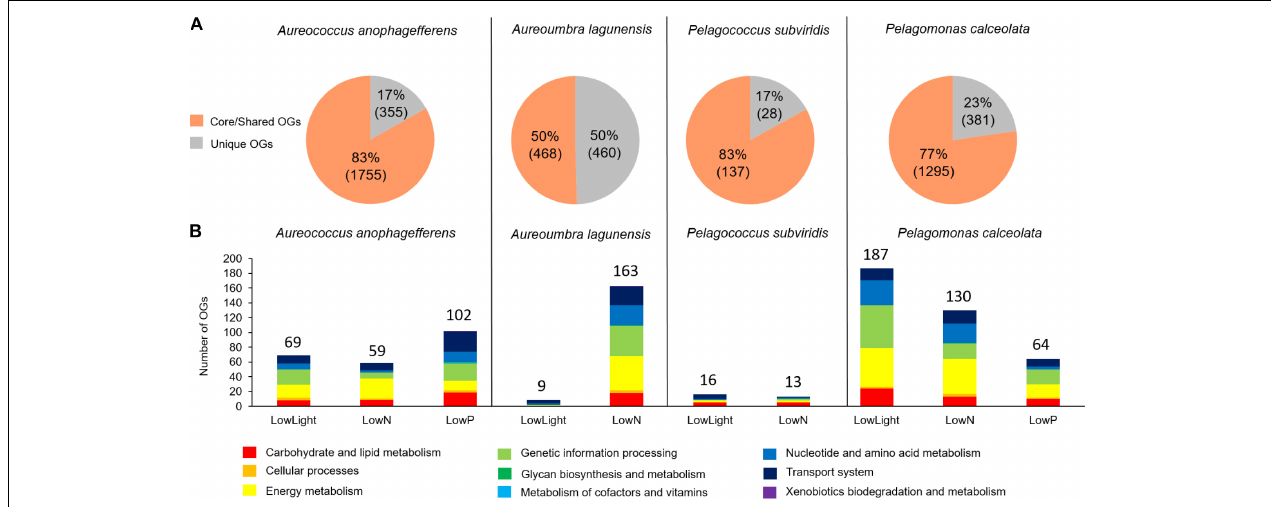
FIGURE 5 | KEGG pathways of differentially abundant OGs from each species. (A) Proportion of core/shared and unique KEGG annotated and differentially abundant OGs, (B) KEGG modules that were annotated based on KEGG database and were differentially abundant among pelagophytes in response to three